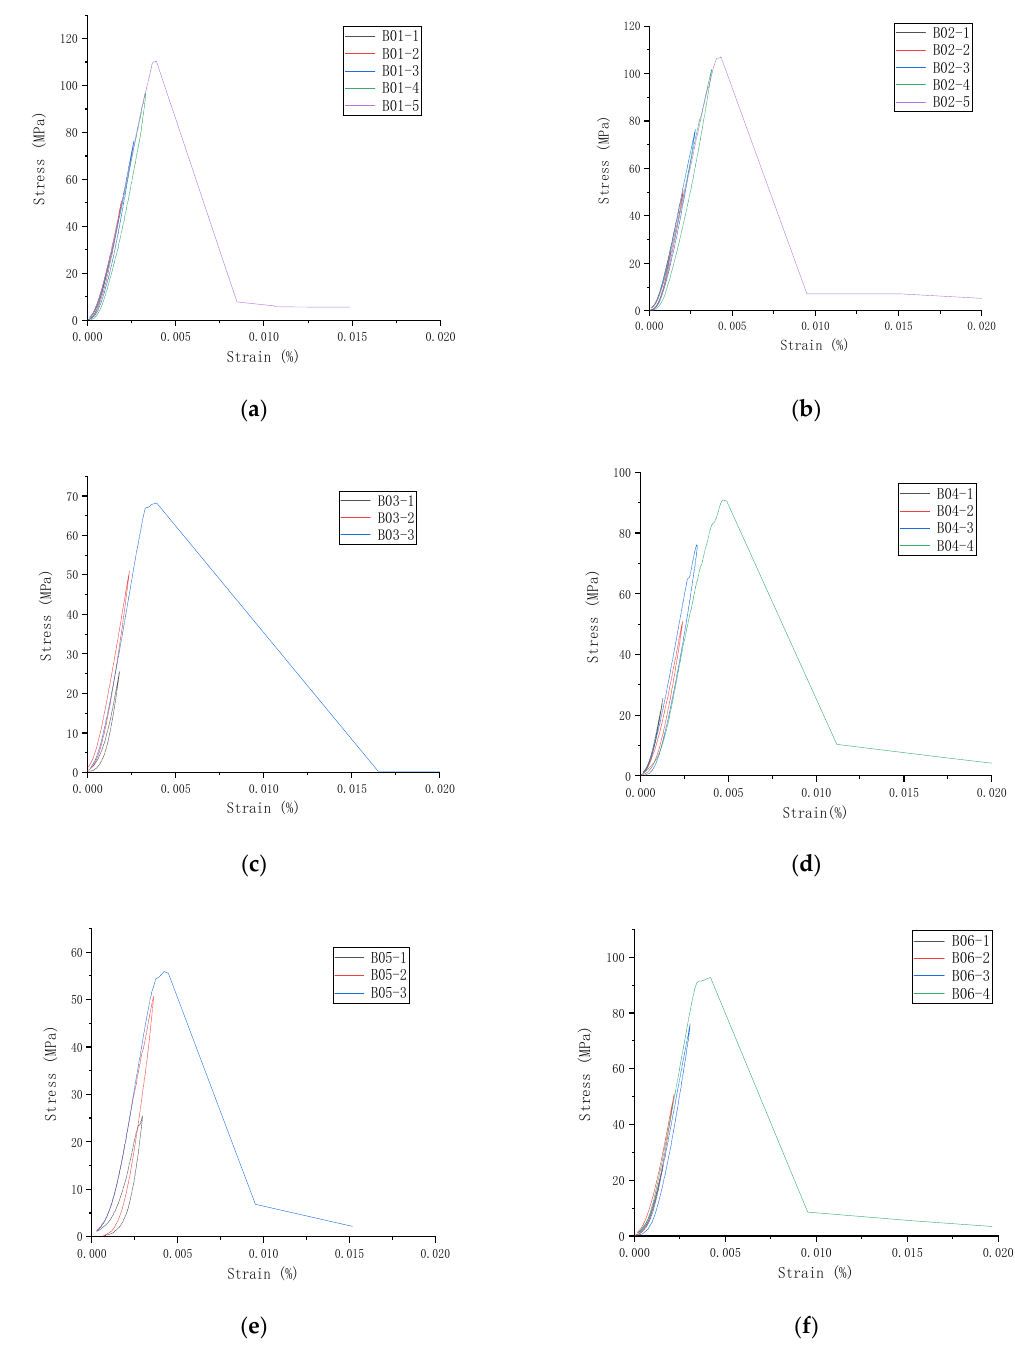
Figure 13. Uniaxial graded cyclic loading and unloading stress–strain curves of rock. ( a ) Stress–strain curve of B01. ( b ) Stress–strain curve of B02. ( c ) Stress–strain curve of B03. ( d ) Stress–strain curve of B04. ( e ) Stress–strain curve of B05. ( f ) –strain curve of B06. From the uniaxial compression stress–strain curve of the rock sample in Figure 12, it can be seen that the stress–strain curve does not show a yielding phase that obviously Table 2. Strength data of rock sample in the uniaxial compression test. produces plastic deformation when the rock sample is about to reach the peak strength, Rock which indicates that this metasandstone is a typical plastic ‐ elastic rock. The deformation